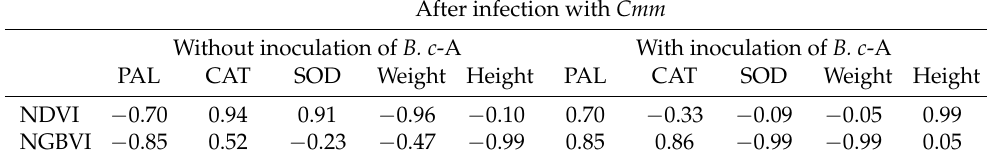
Without inoculation of B. c -A With inoculation of B. c